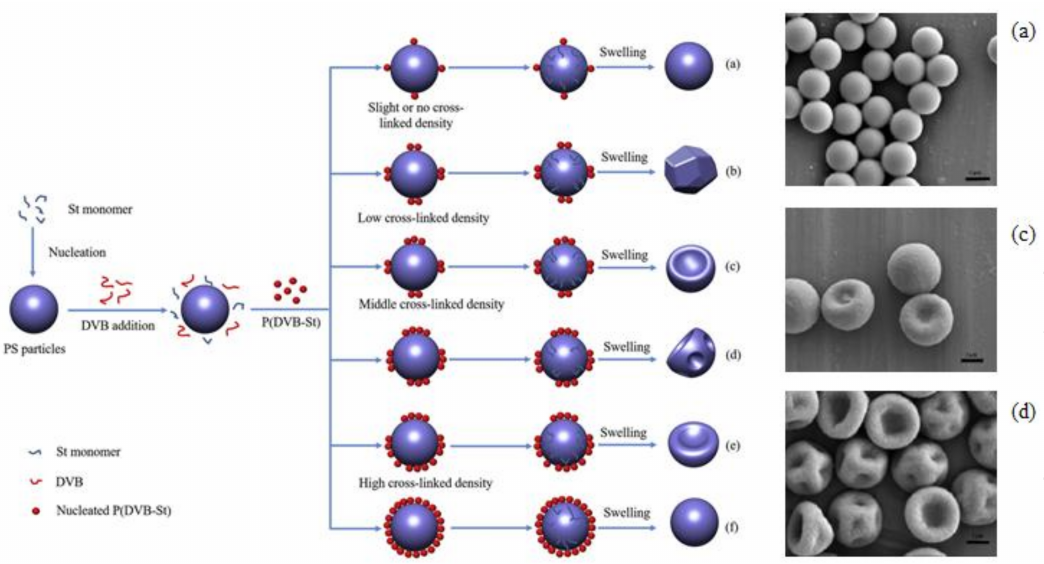
Figure 4. Nonspherical single microgels prepared using buckling instability. ( left ) Possible formation mechanism of the buckling of microgels with various surface morphologies; ( right ) Scanning electron microscopy (SEM) micrographs of microgels synthesized by varying the divinylbenzene (DVB) concentration based on total styrene (St) monomer mass, ( a ) 0 wt %, ( c ) 0.5 wt % and ( d ) 2.0 wt %. The scale bars are 1 µ m. (H. Shen et al., Copyright 2017